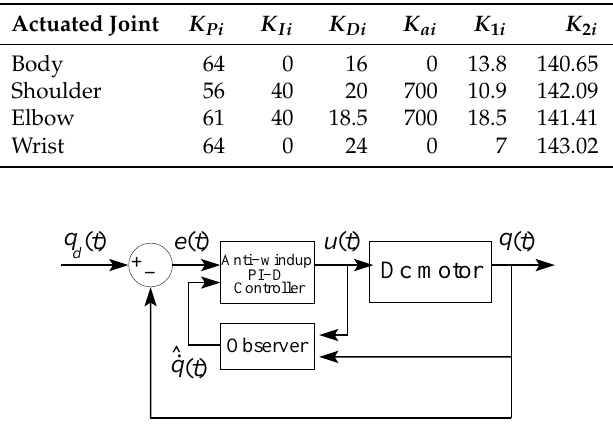
Figure 8. PID controller coupled to the state